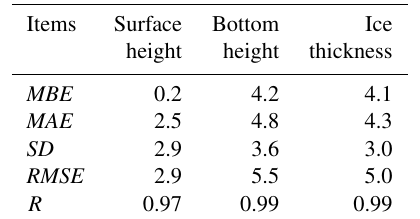
Table 2. The mean bias error ( MBE ), mean absolute error ( MAE ), standard deviation ( SD ), root mean square error ( RMSE ), and corre- lation coefficient ( R ) between modeled and observed ice mass bal- ance components with n = 4023 (in centimeters).